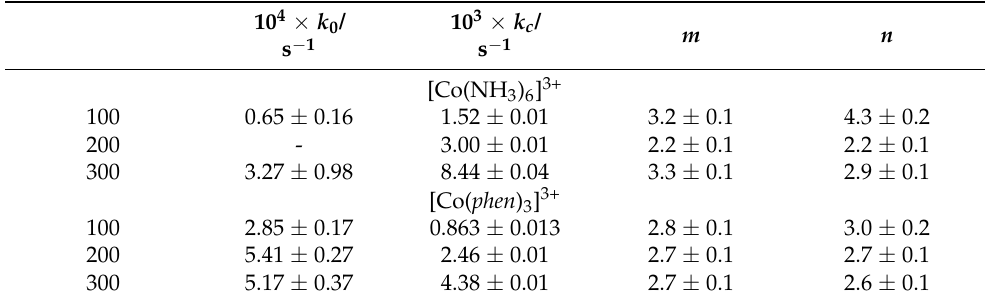
Table 1. Relevant kinetic parameters for the J-aggregation of H 2 TPPS 4 ( k 0 , k c , m and n ) as function of [CoL n3+ ] (pH = 2, T = 298 K).